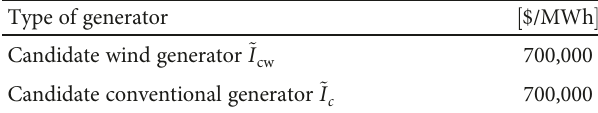
Table 12: Investment costs.